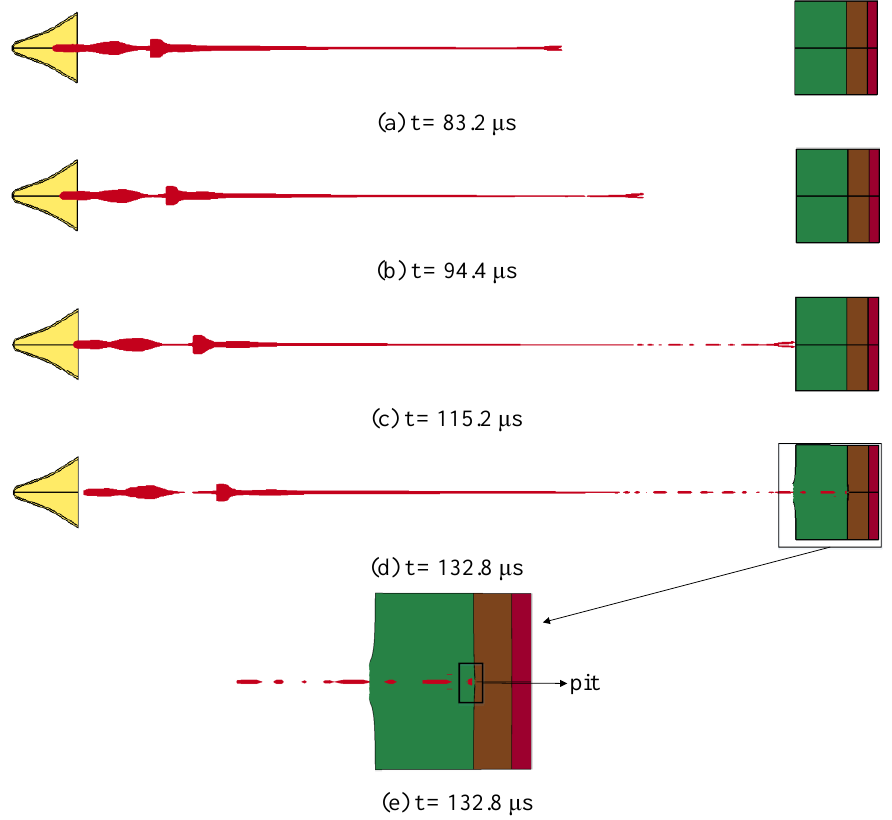
Figure 7. Penetration result without the simulation cabin.